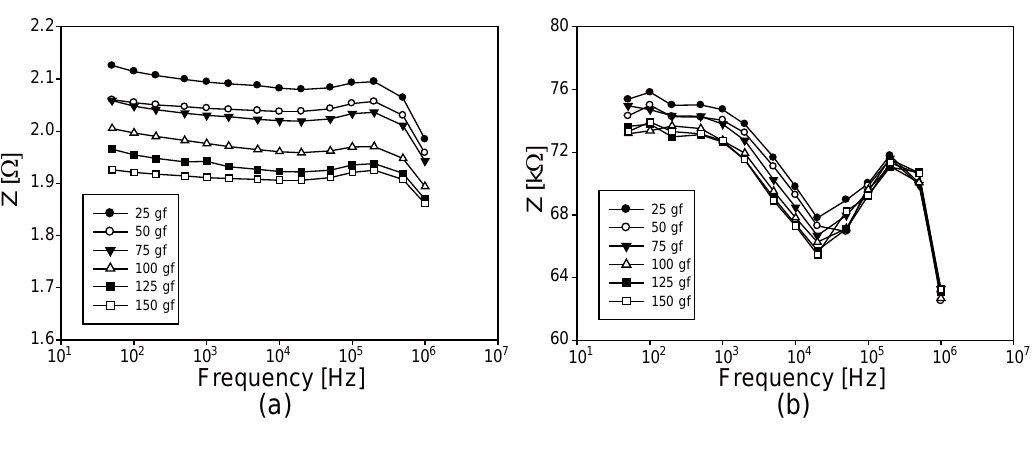
Figure 11. Impedance magnitude spectra of three conductive fabrics under compression. ( a ), ( b ), and ( c ) are from the fabrics A, B, and C, respectively; ( d ) shows the plots of the impedance magnitude changes at 10